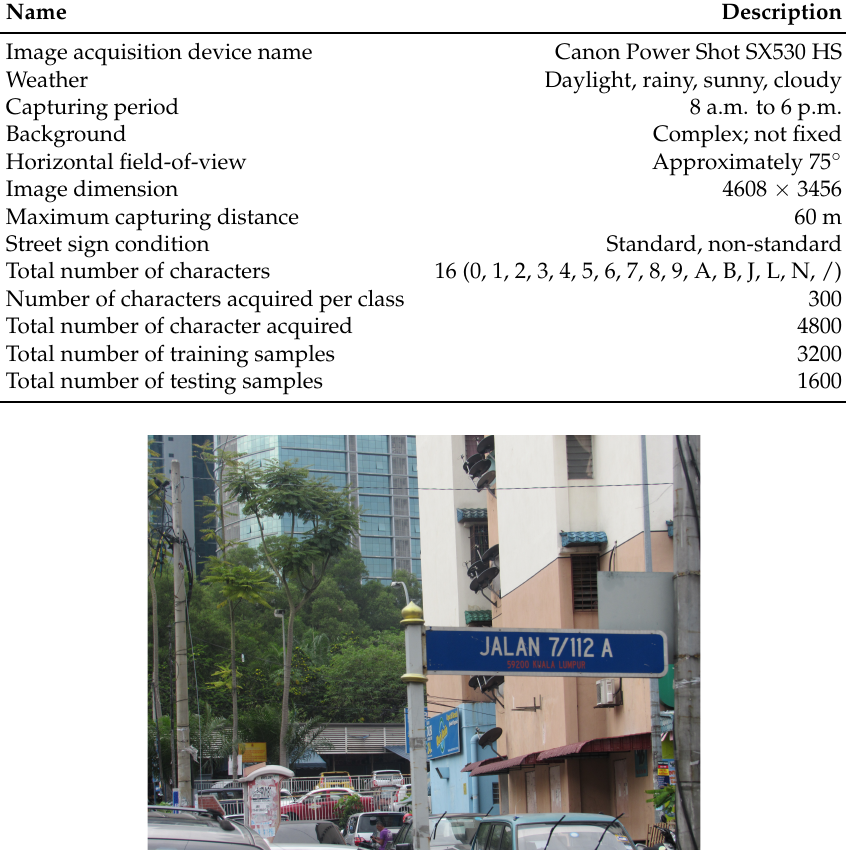
Figure 2. An example of a Malaysian street